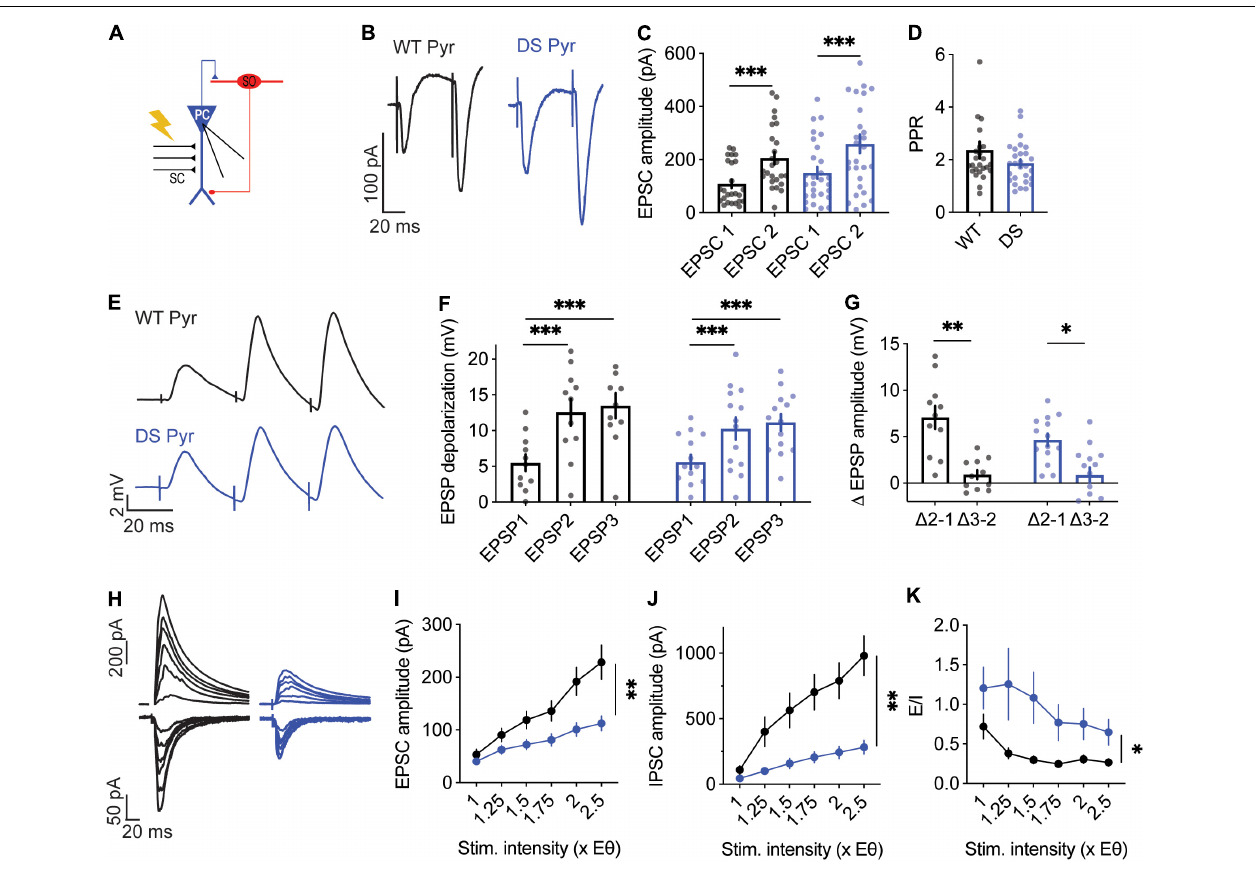
FIGURE 6 | Altered excitatory and inhibitory synaptic currents in DS Scn1a A1783V / WT CA1 pyramidal neurons. (A) Illustration of the stimulation setup. The stimulating electrode was placed on the CA3 SC while the CA1 pyramidal neurons were measured using whole-cell patch clamp. (B) Representative traces of WT (black) and DS (blue) paired-pulse responses. (C) Average EPSC amplitudes of the 1st and 2nd stimuli that were given within 50 ms. Statistical analysis utilized Two Way repeated measures ANOVA. The markings depict the results of Bonferroni post hoc analysis: p = 0.167 for genotype; p < 0.0001 ( ∗∗∗ ) for the EPSC number; and p = 0.62 for the interaction. (D) Paired-pulse ratio (EPSP2/EPSP1). Statistical analysis utilized the Mann–Whitney test. WT: n = 13 cells from 4 mice, DS: n = 13 cells from 3 mice. (E) Representative EPSPs in WT and DS CA1 pyramidal neurons in response to a train of stimuli at 30 Hz. (F) EPSP amplitude at each of the three stimuli. Statistical analysis utilized Two Way Repeated Measures ANOVA. The markings depict the results of Bonferroni post hoc analysis: p = 0.43 for genotype; p < 0.001 ( ∗∗∗ ) for the EPSP number; p = 0.07 for the interaction. (G) The added depolarization of each EPSP. Statistical analysis utilized Two Way Repeated Measures ANOVA. The markings depict the results of Bonferroni post hoc analysis: p = 0.052 for genotype; p < 0.001 ( ∗∗∗ ) for the EPSP number; p = 0.25 for the interaction. WT: n = 13 cells from 4 mice; DS: n = 13 cells from 3 mice. (H–J) Representative traces (H) , average EPSCs (I) and IPSCs (J) evoked by SC stimulation at different stimulation intensities from WT and DS mice. EPSCs were measured at a holding potential –60 mV, and IPSCs were measured at 0 mV. Statistical analysis utilized Two Way Repeated Measures ANOVA. For the EPSCs: p = 0.009 ( ∗∗ ) for genotype; p < 0.001 ( ∗∗∗ ) for the interaction; for the IPSCs: p = 0.001 ( ∗∗ ) for genotype; p < 0.001 ( ∗∗∗ ) for the interaction. (K) E/I ratio. Statistical analysis utilized Mixed Model Repeated Measures ANOVA: p = 0.01 ( ∗ ) for genotype; p = 0.001 ( ∗∗ ) for the stimulation intensity; p = 0.3 for the interaction. WT: n = 15 cells from 3 mice; DS: n = 13 cells from 3